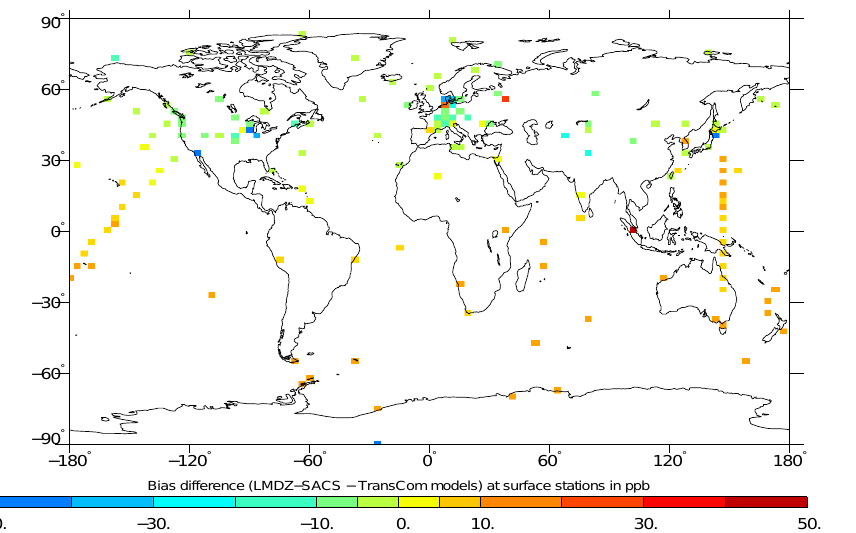
Fig. 6. Bias between CH 4 mixing ratios simulated by LMDZ-SACS and other TransCom models ( y LMDZ − y TransCom ; y TransCom is the average of CH 4 mixing ratios simulated by all TransCom models) at surface stations. The bias is expressed in ppb.